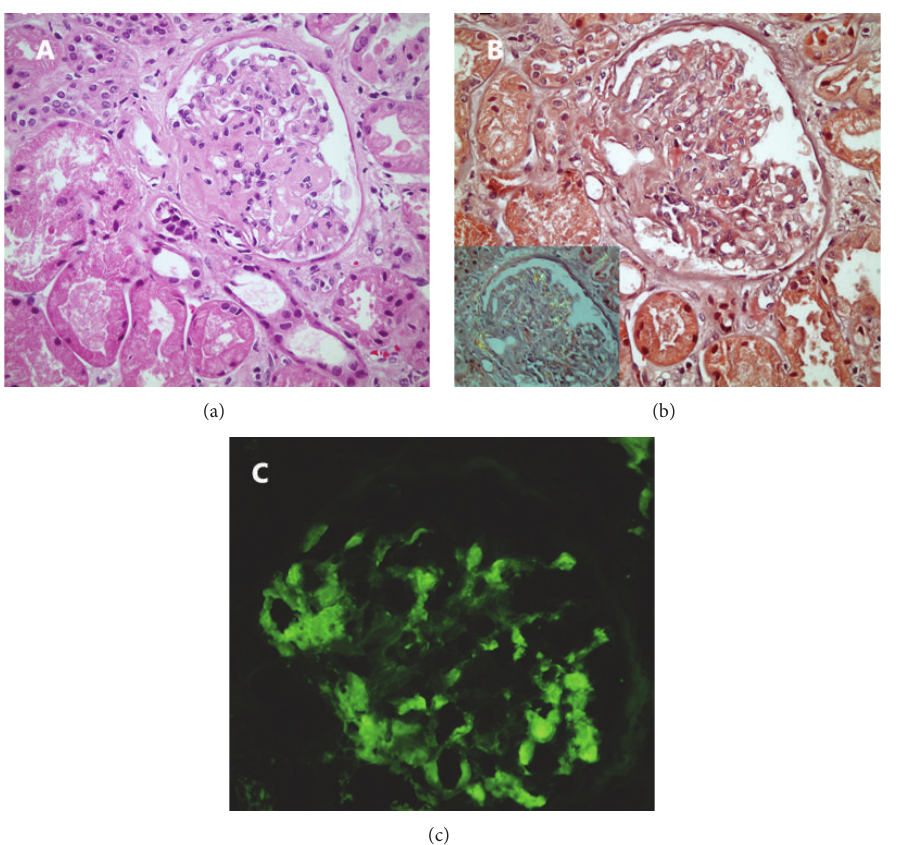
Figure 1: (a) Homogenous pale eosinophilic material accumulation in the glomerulus and in the hilar arteriole (H&E, × 400). (b) Positive Congo red staining in the areas of glomerular deposition (Congo red stain, × 400). Inset shows apple green birefringence given by deposits under polarized light (Congo red stain with polarized microscopy, × 200). (c) Amyloid was strongly reactive for lambda light chain on immunofluorescence microscopy (immunofluorescence, fluorescein isothiocyanate-conjugated anti-lambda antibody, × 400).